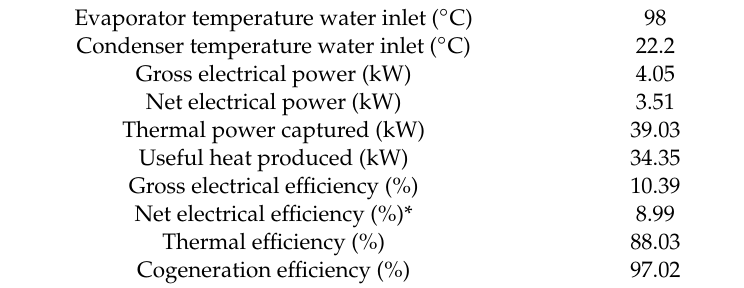
Table 6. Main characteristics of ORC at the point of maximum e ffi ciency